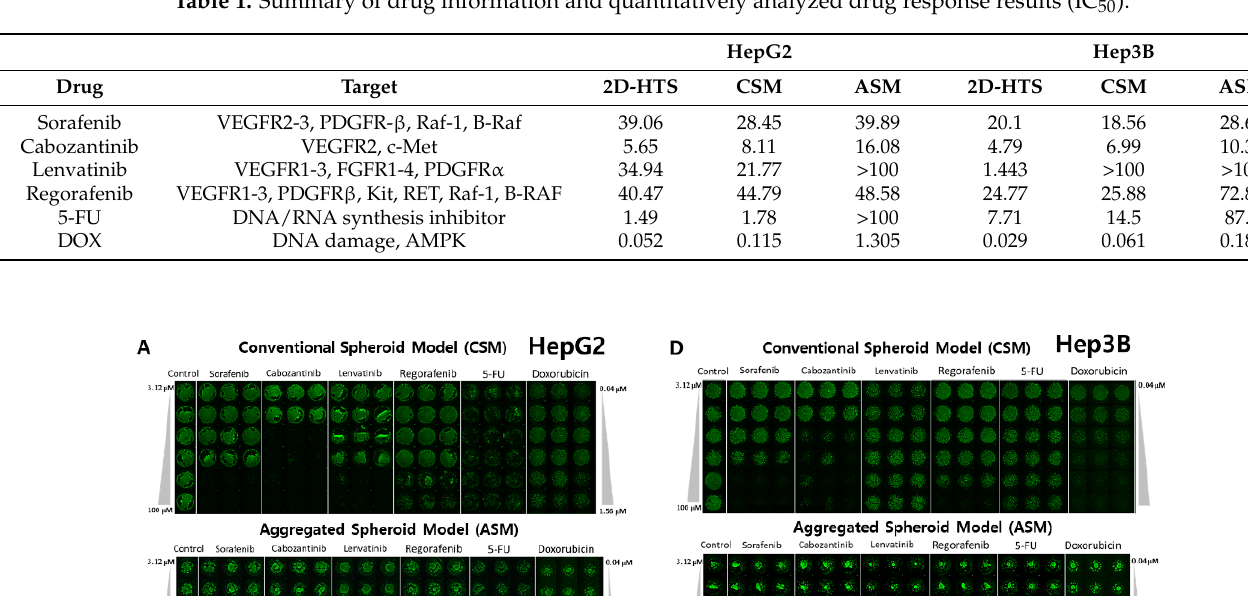
Table 1. Summary of drug information and quantitatively analyzed drug response results (IC 50 ).